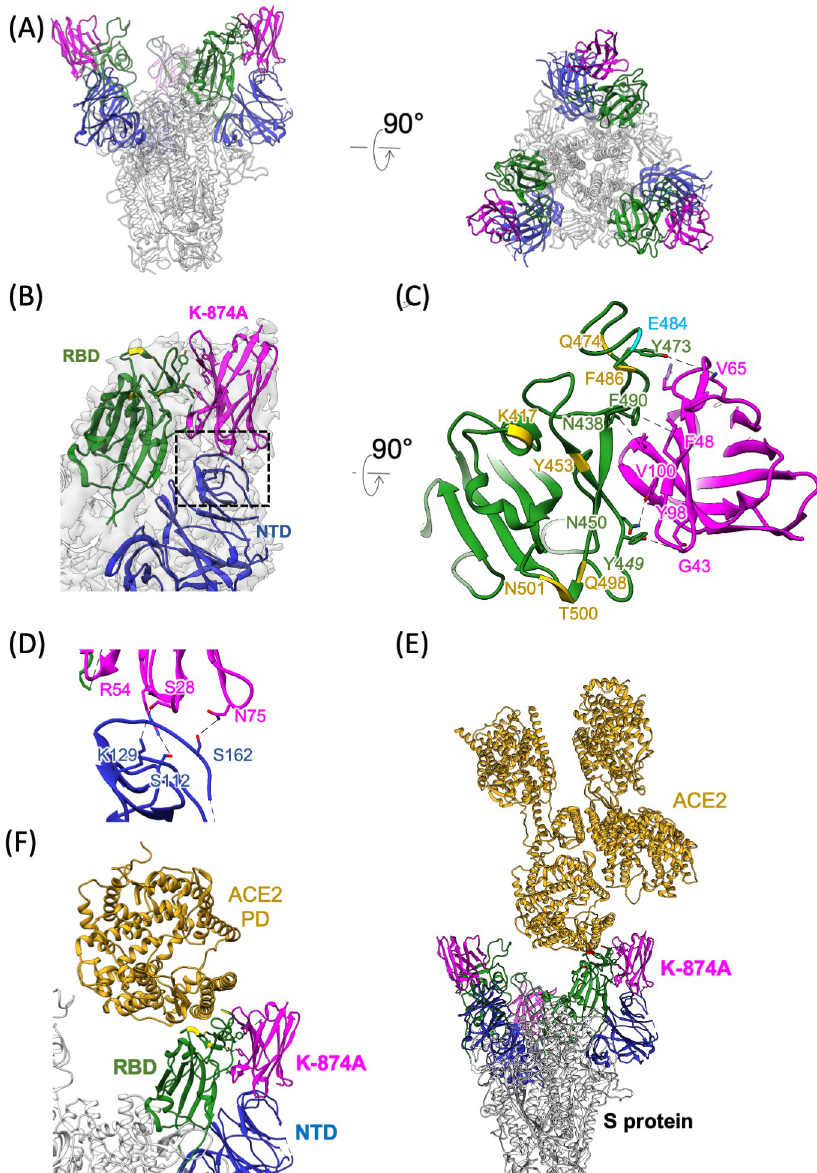
Fig 3. K-874A-binding region on the S protein in the major cryo-EM map (type 1). ( A ) A ribbon model of S protein trimer and K-874A VHHs. The coloring follows the standard designation of K-874A VHH (magenta), NTD (blue) and RBD (green). ( B ) An enlarged view of RBD, NTD and K-874A in (A). ( C ) A view of the structure in (B) rotated 90˚. Residues that interact with ACE2 are shown in yellow. N501 and E484 (cyan) are amino acid residues frequently mutated. Possible chemical interactions between RBD and K-874A are shown with black dotted lines. ( D ) Possible chemical interactions between K-874A and NTD shown with black dotted lines. The viewing area was indicated by the dotted square in (B). ( E ) The binding of K-874A and ACE2 on RBD. ( F ) A close-up view of the interactions between the peptidase domain (PD) of ACE2, K-874A, RBD, and NTD. K-874A does not interfere the binding of